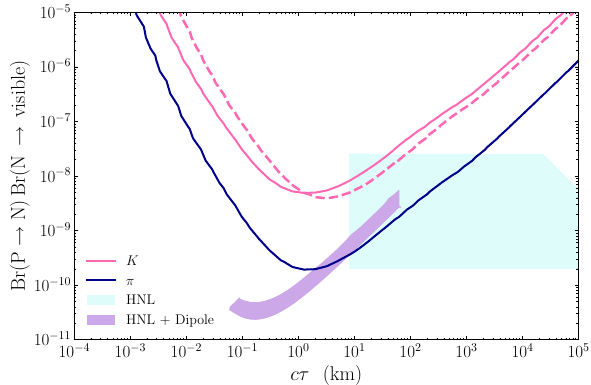
Fig. 2 Limits at 90% confidence level (CL), on the plane Br ( K /π → N ) × Br ( N → visible ) versus c τ for m N = 0 . 1 GeV (solid) and m N = 0 . 25 GeV (dashed), for HNL produced in π (dark blue) or K (pink) decays. Our limits have been obtained assuming uncorrelated production and decay mechanisms for the HNL. The shaded light blue region corresponds to the (correlated) values obtained for the minimal model, varying the mixings within their presently allowed constraints as explained in the text. The purple area corresponds to the 1 σ allowed region where a HNL with a dipole interaction could explain the Mini- BooNE anomaly, according to Ref. [42], for m N = 260 MeV